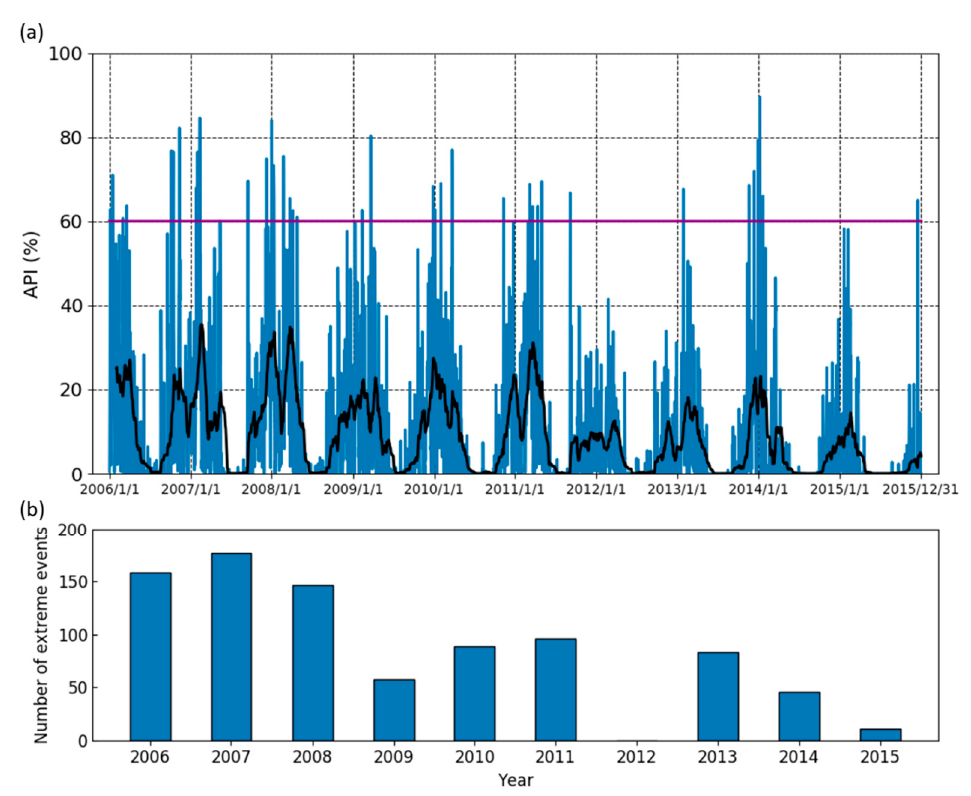
Figure 2. ( a ) Air Pollution Index (API) from 2006 through 2015 is represented by the blue line. The black line shows the one-smooth running average of API, and the horizontal purple line is the 60% threshold value to define extreme events. ( b ) The number of extreme events (API > 60%, 99 percentile) from 2006 to 2015 is represented by the blue bars.